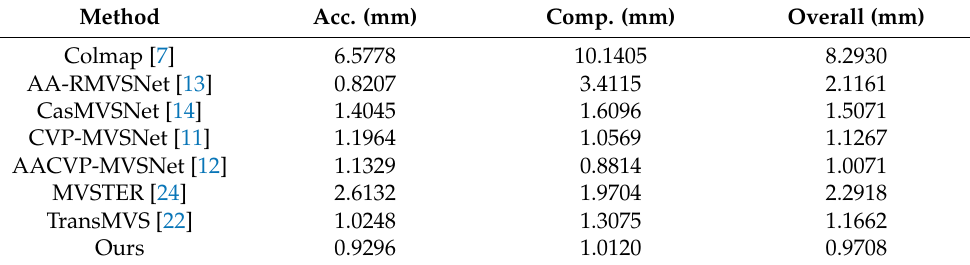
Table 1. Comparison of reconstruction quality in objective metrics.